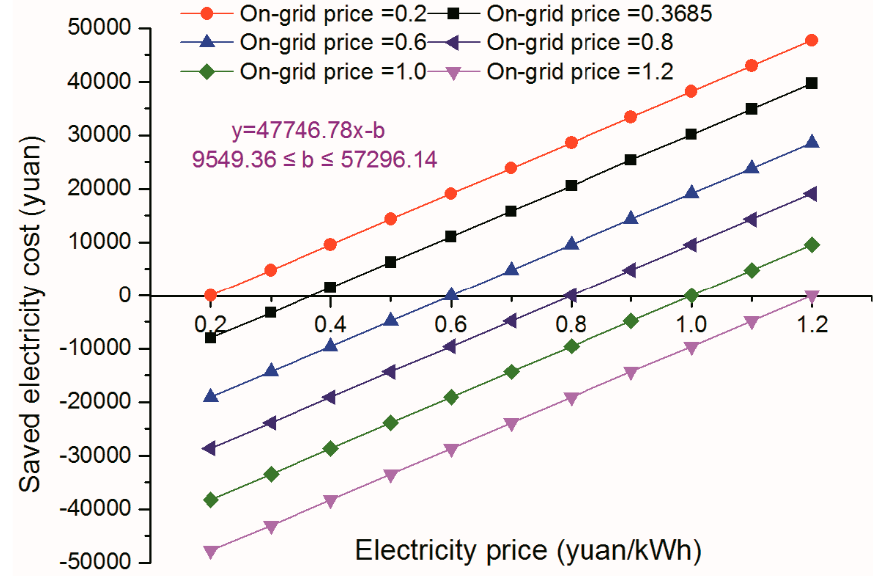
Figure 12. Electricity cost saved by the turbine-driving mode under different.